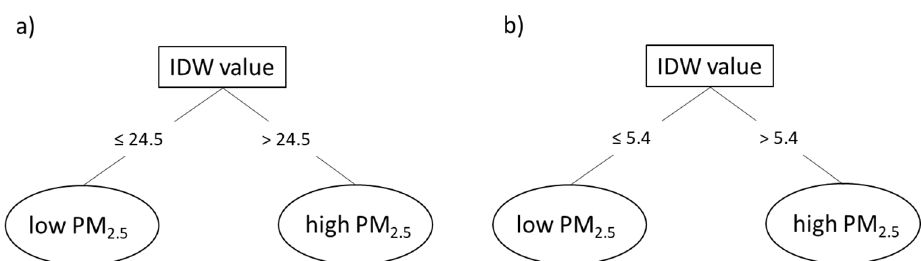
Figure 6. Decision tree models to predict the levels of contamination by PM 2.5 (high vs. low) according to an IDW interpolation of the concentrations measured at the four monitoring stations (Belisario, Centro, Cotocollao, and El Camal). The two models correspond to the days as follows: ( a ) 12 June, 2019 and ( b ) 3 June, 2019. The numbers indicate the cutoff values (in µg m − 3 ) that permit the best split on the predictor (i.e., IDW) to separate low and high concentrations of PM 2.5 .